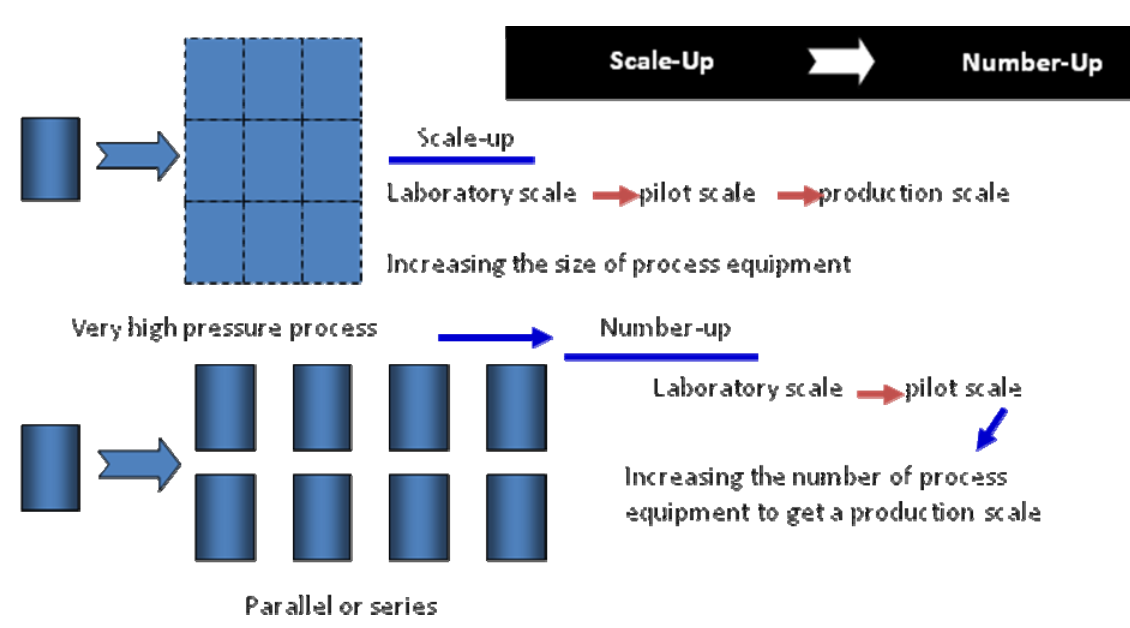
Figure 2. Scale-up to larger, geometric full-scale